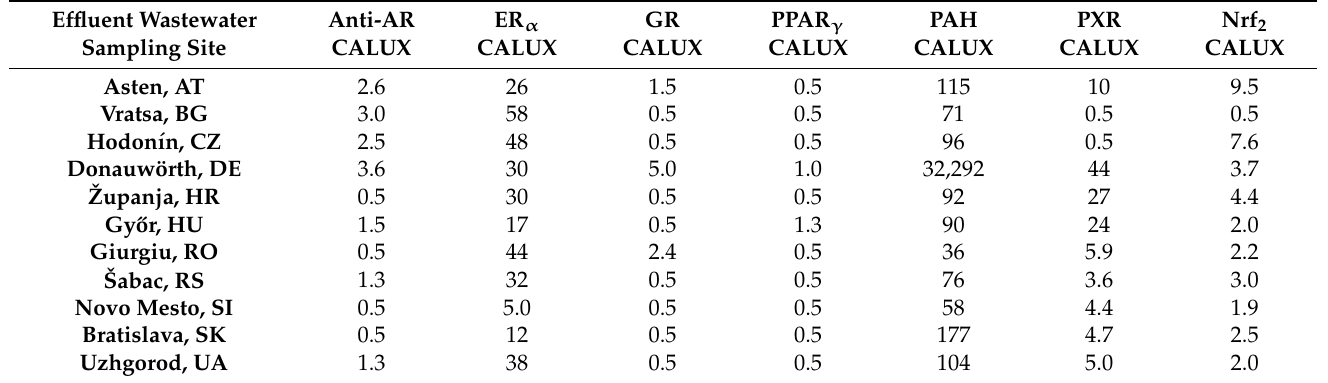
Table 3. Normalized results of the battery of CALUX bioassays of the 11 studied effluent wastewater